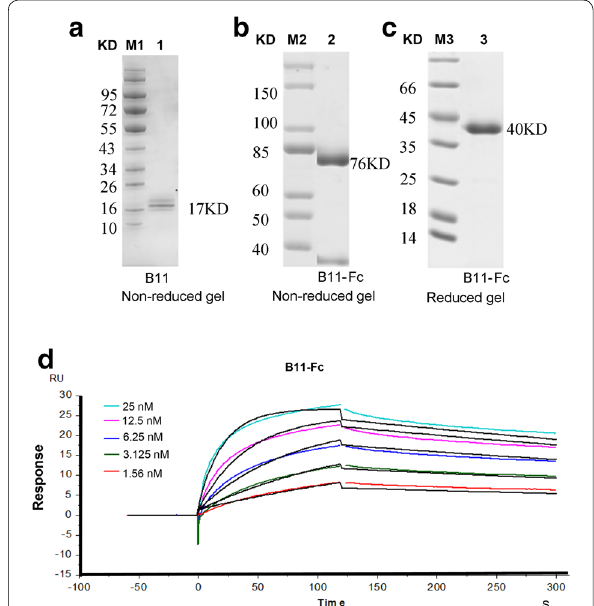
Fig. 5 The SDS-PAGE gel and the affinity tests. a – c the SDS-PAGE gel of the VHH-B11, and the bivalency B11-Fc. M1, M2 and M3: the protein markers (Fermentas, USA). Lane1: VHH-B11, 17 kDa Lane2: B11-Fc, 76 kDa non-reduced gel; Lane3: B11-Fc, 40 kDa reduced gel. d The affinity test of the bivalency B11-Fc. Each colored line represents one antibody concentration. The black lines represent the automatic fitting curves by the built-in evaluation software. The binding and dissociation time was set at 180 s and 240 s, respectively, and the protein injection time point was automatically set as 0 s by the built-in evaluation